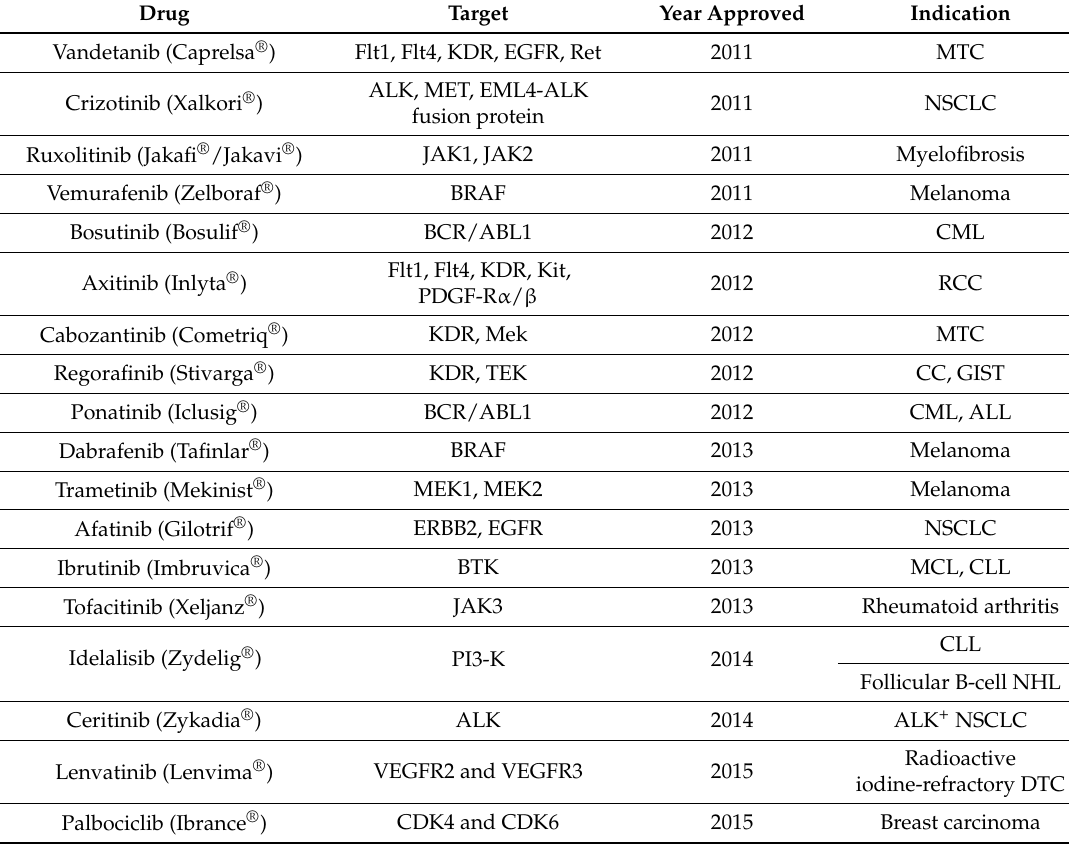
Table 1. Approved tyrosine kinase inhibitors in human medicine, 2011–2015 a . Drug